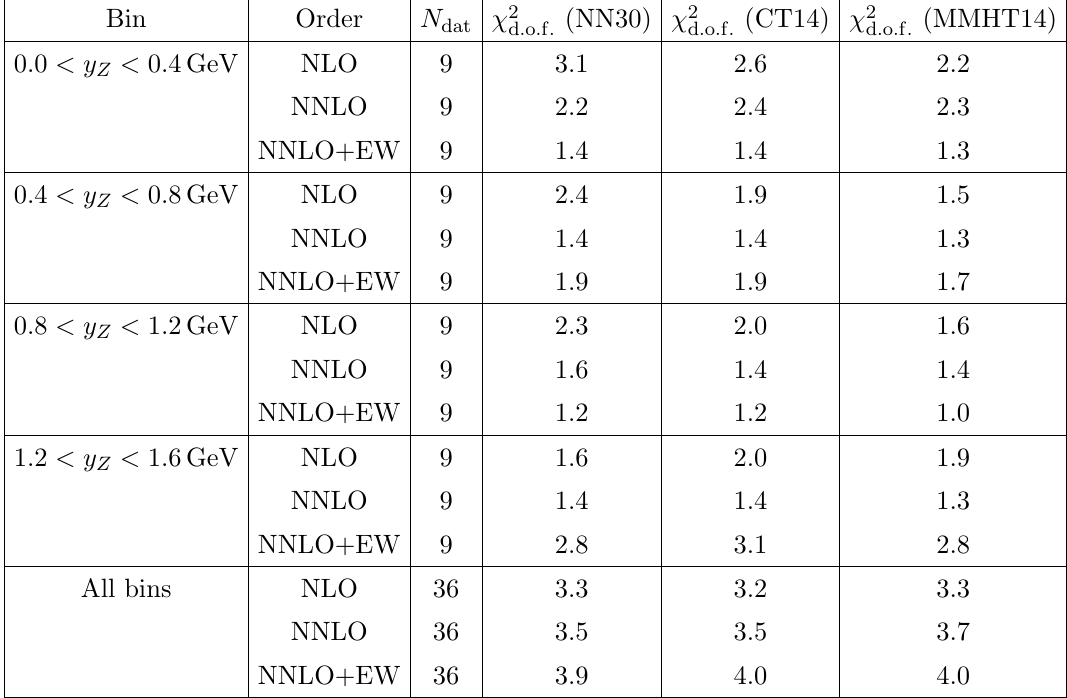
Table 4 . Same as table 1 for the CMS 8 TeV p Z their inclusion in the